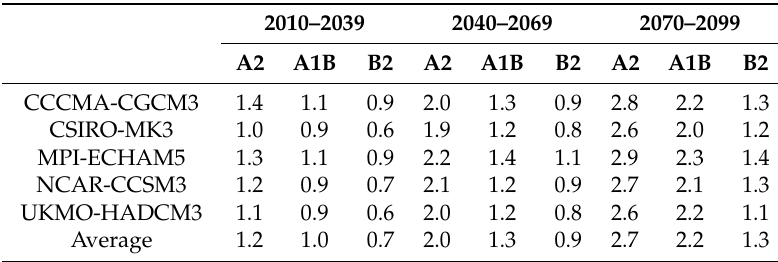
Table 4. Downscaling results for temperature in Zambezi Basin. Values in the table represent the Delta change ( ˝ C) relative to the reference period